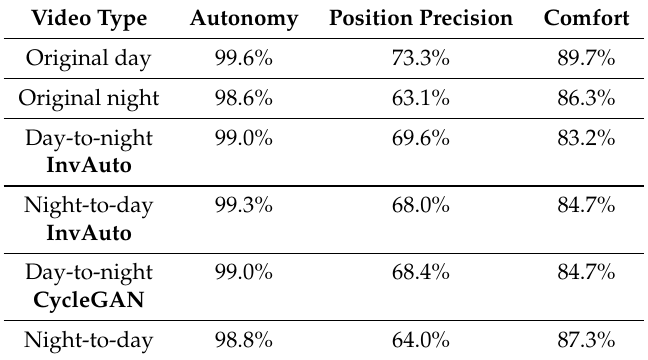
Table 4. Experimental results with autonomous driving system: autonomy, position precision, and